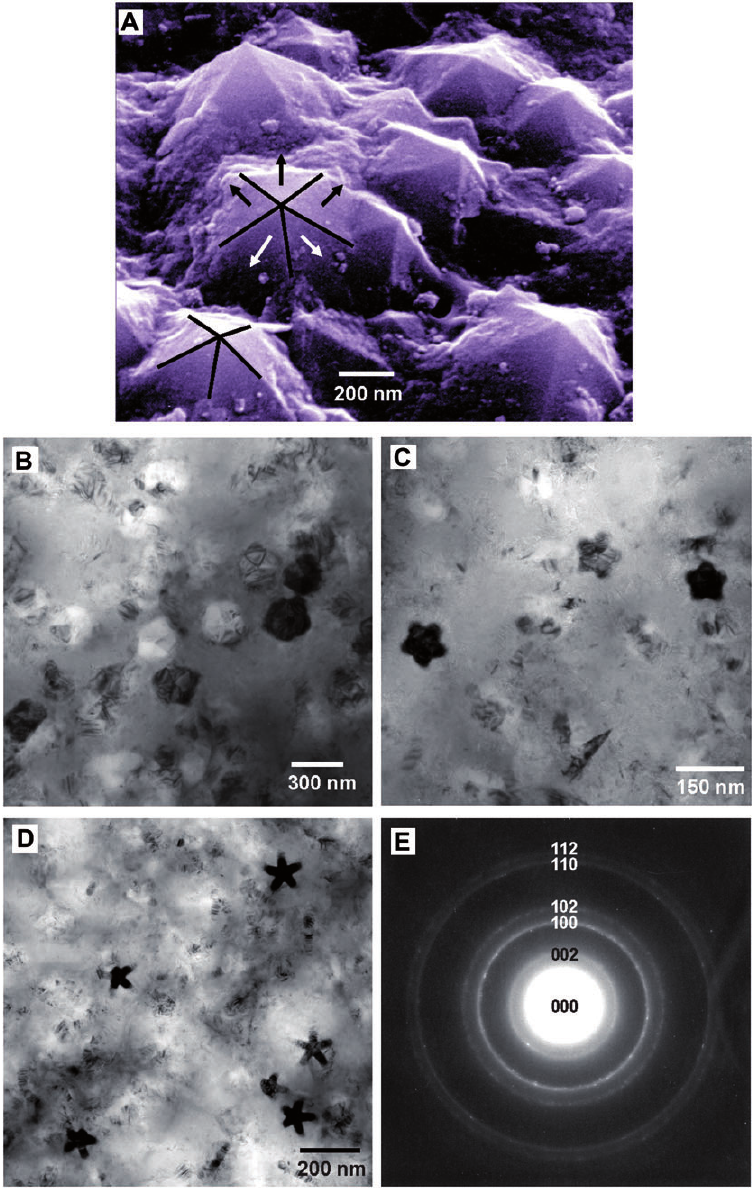
Figure 28 (A) SEM image of BN nanoparticles. TEM images of CVD-BN nanoparticles, synthesized from a BCl deposition temperatures of (B) 2000 ° C and (C) 1800 ° C and synthesized from (D) B